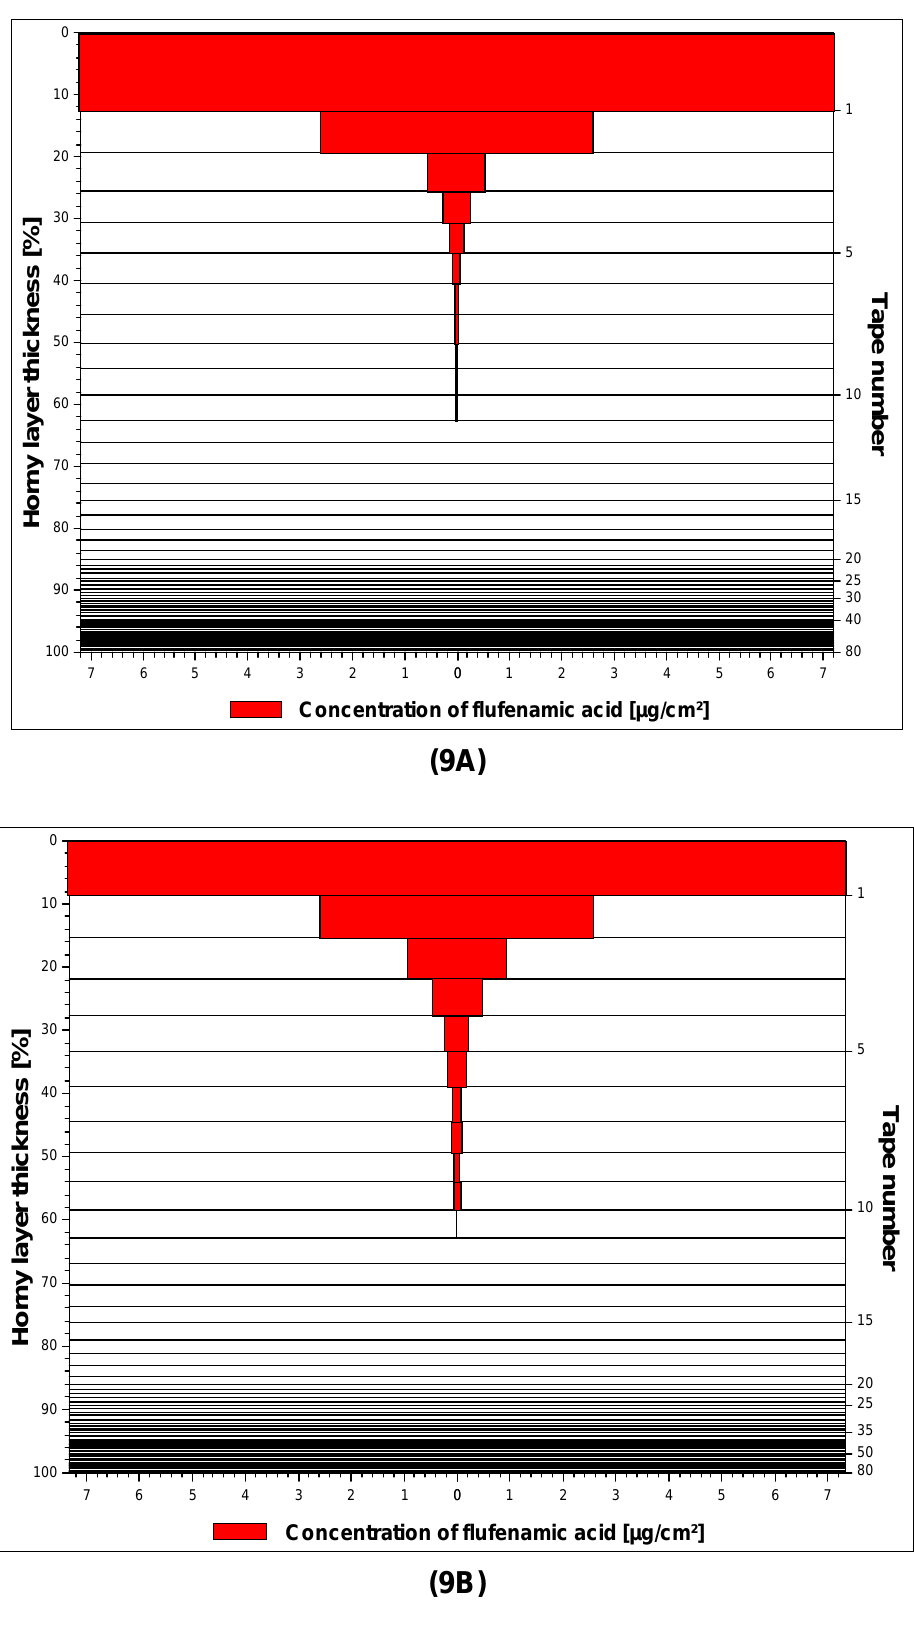
Figure 9. In vitro skin penetration profiles of flufenamic acid applied topically in macroemulsions (9A) and nanoemulsions (9B) . The data were obtained via tape stripping using porcine ear skin (n = 8,